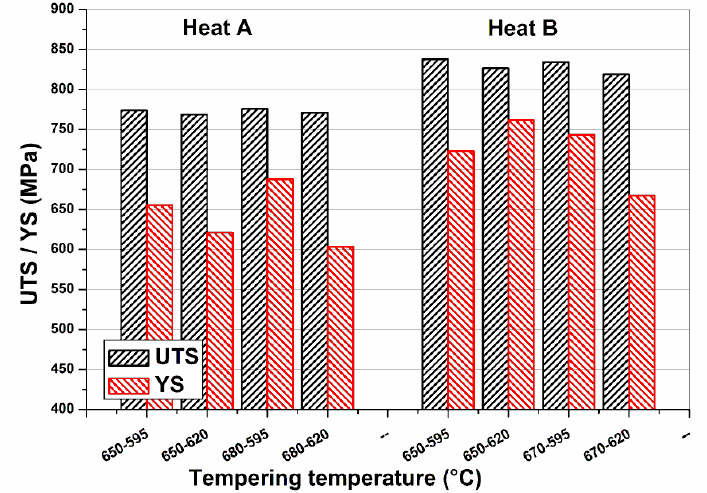
Figure 12. YS and UTS of Heat A and Heat B following double temper treatments.